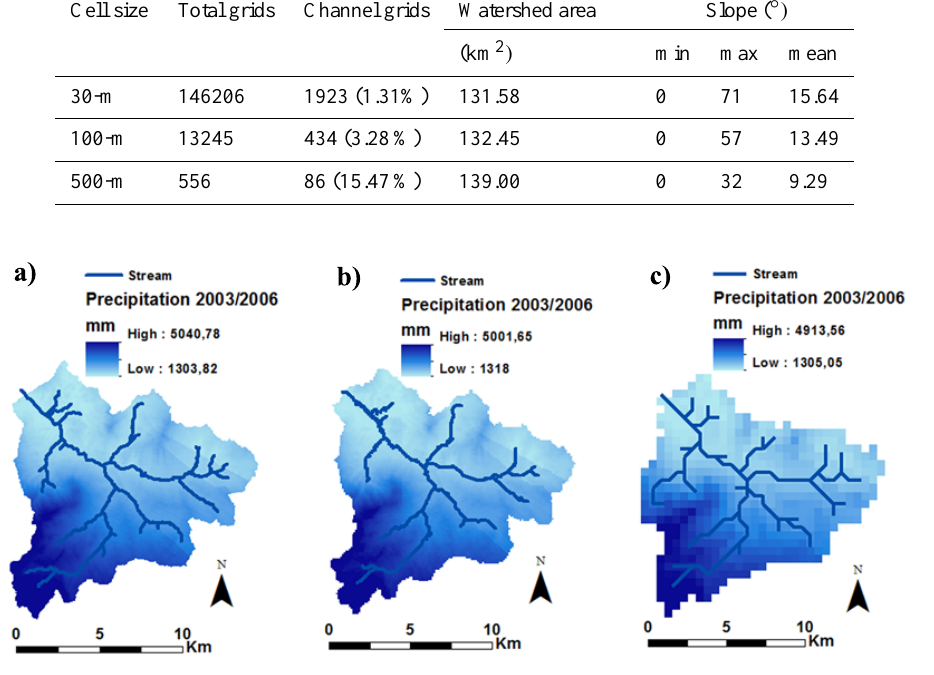
Fig. 2. Accumulated distributed precipitation (2003–2006) in mm and drainage network for (a) 30-m cell size, (b) 100-m cell size, and (c) 500-m cell size.